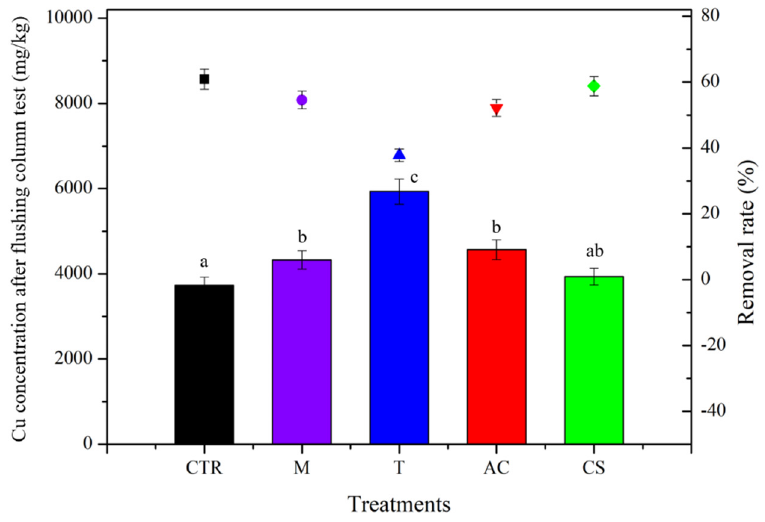
Figure 4. Cu concentration remaining in the soil (bar chart) and the removal rate (symbol dot) after column leaching test with and without amendments at a flow rate of 1 mL/min condition. Means with the same letters are not significantly different from each other under different amendment treatments according to Tukey’s test ( p < 0.05, n = 3) (CTR: control; M: magnetite; T: talc; AC: activated carbon; CS: cornstarch). carbon; CS: cornstarch).